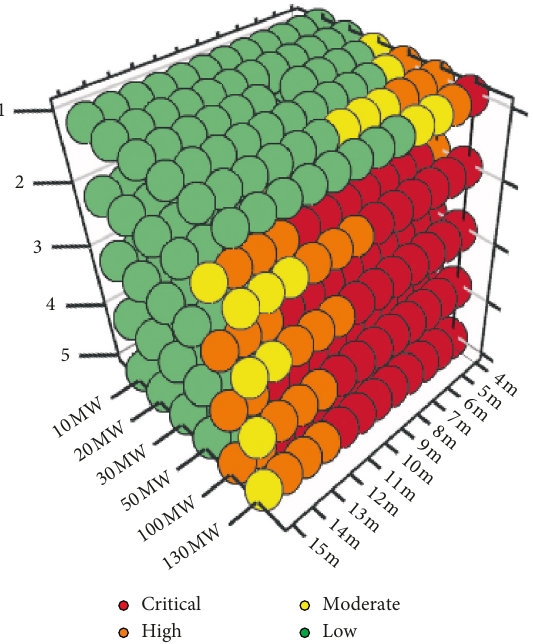
Figure 8: Risk grade model for concrete bridges.